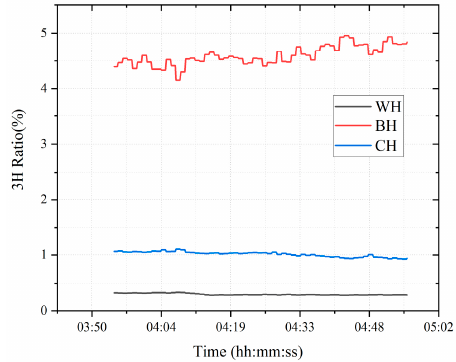
Figure 5. 3H ratio diagram of Well B.